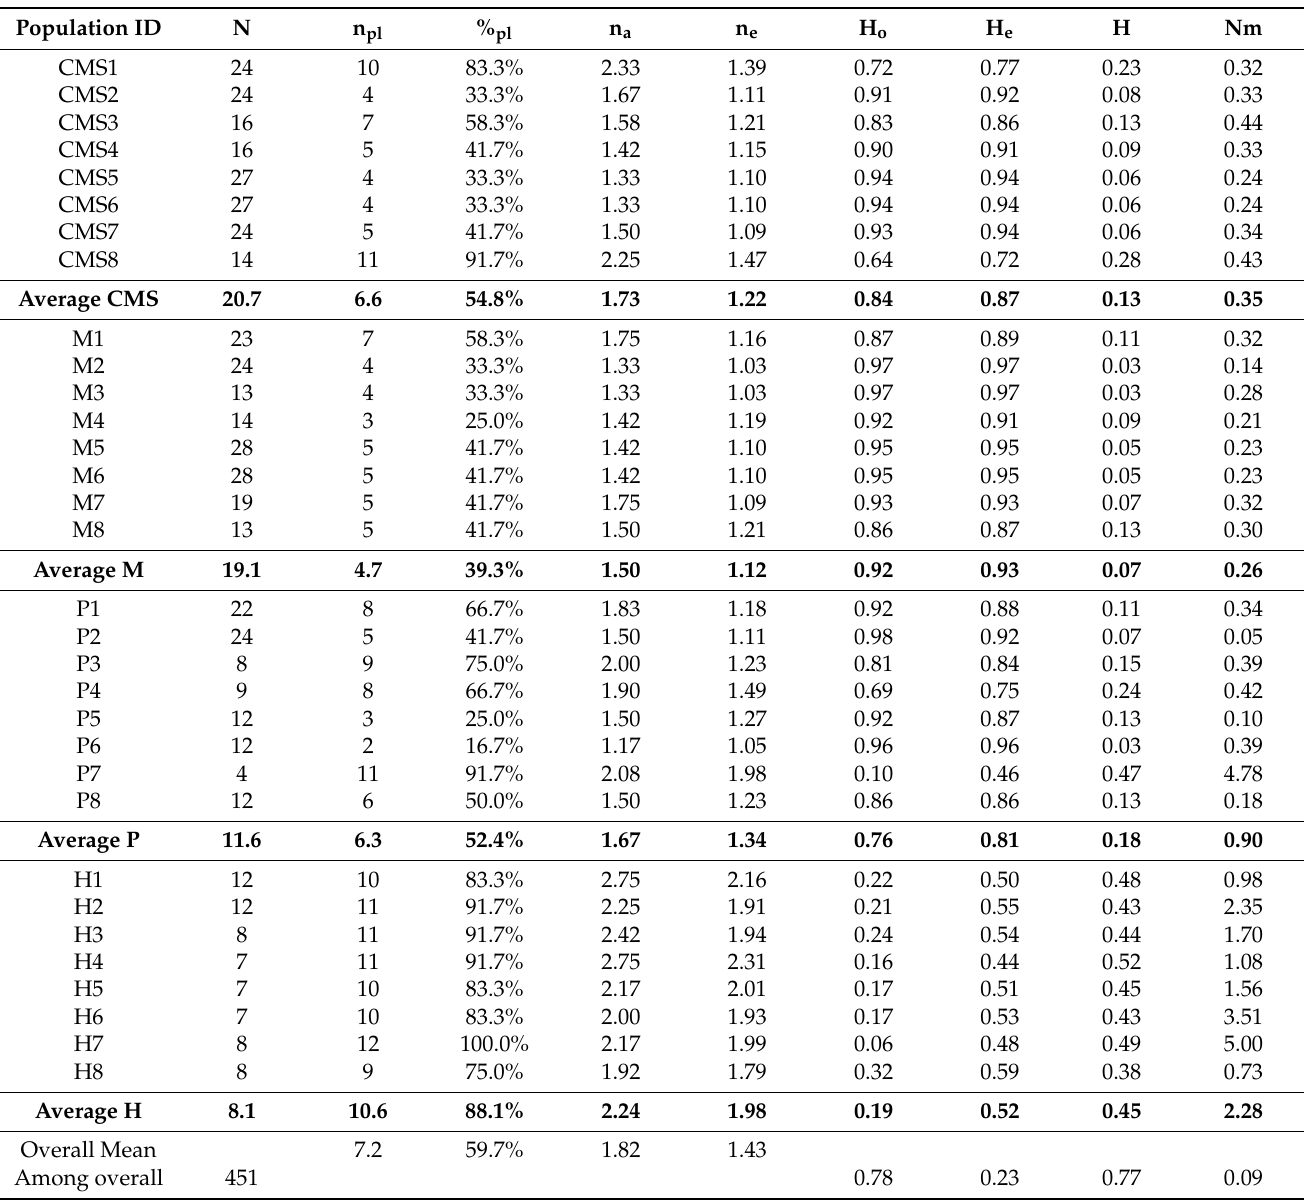
Table 3. Descriptive statistics for all SSR loci, including number of individuals (N), number (n pl ) of polymorphic loci, percentage (% pl ) of polymorphic loci, mean number of observed (n a ) alleles per locus, mean number of effective (n e ) alleles per locus, observed (H o ) homozygosity, expected (H e ) homozygosity, Nei’s genetic diversity (H) and gene flow estimates